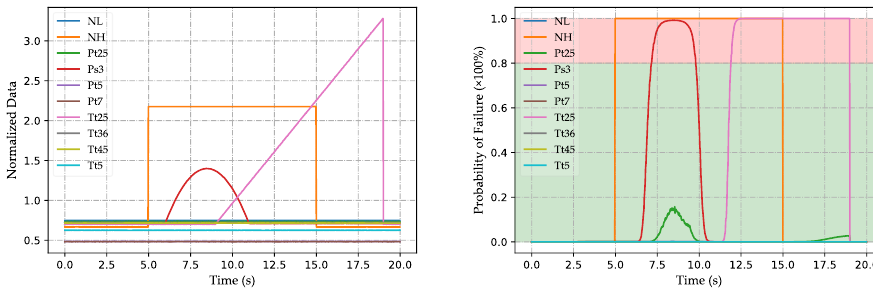
Figure 11. Detection of simultaneous failure of multiple sensors in steady state. The simultaneous failure of multiple sensors in a transition state is shown in Figure 13. Under a specific steady-state condition, the drift, impulse, and bias fault are injected into the NL, Pt7, and Tt5 sensor at approximately 5 s, 3 s, and 9 s, respectively. The detection delay of each fault is approximately 5.9 s, 0.2 s, and 0 s, respectively. The delay in detecting drift faults is due to the fact that the injected drift fault offset is small, and the drift fault itself has the characteristic of slowly increasing the